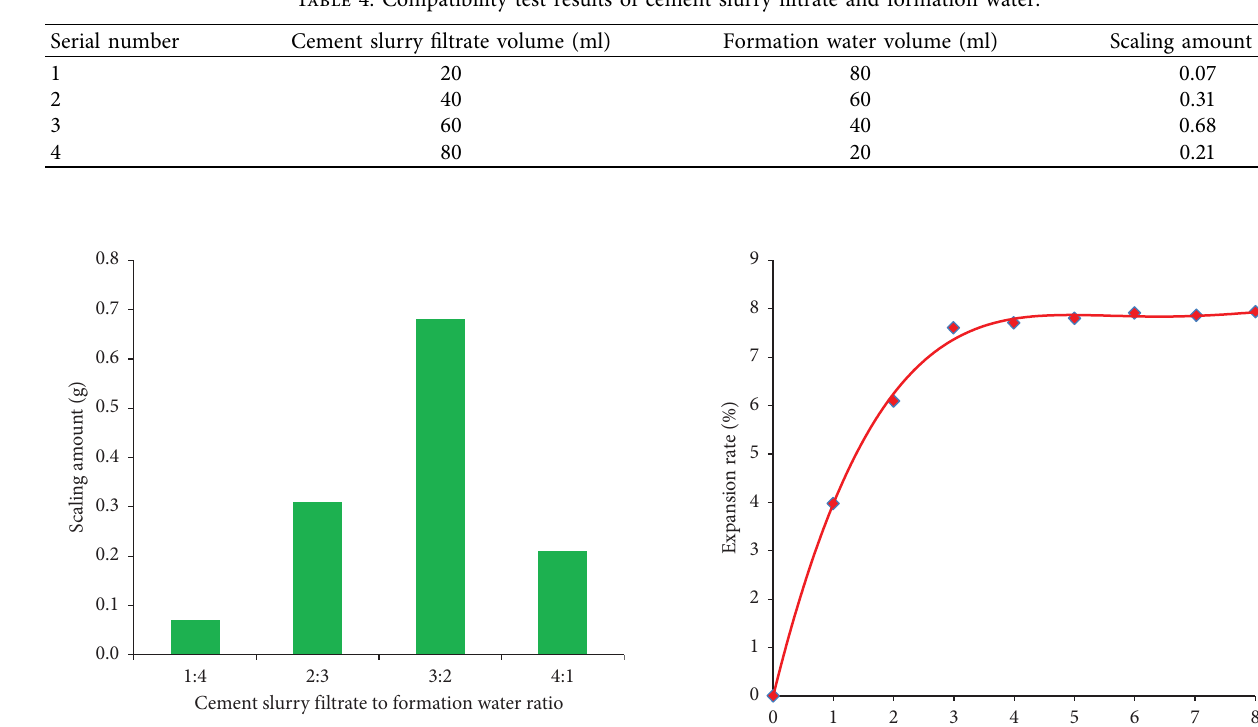
Figure 2: Scaling amount of diferent ratios of cement slurry fltrate and formation water with green synthesis and metal oxide composites.